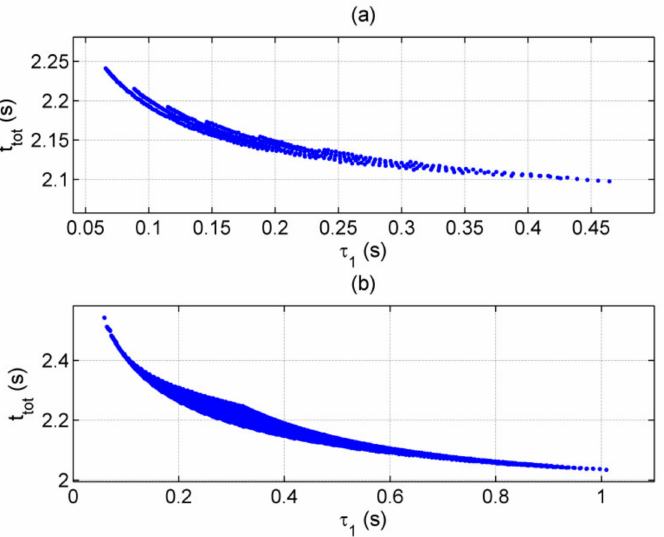
Figure 13. The relationship between the total charging time and time constant τ 1 for the two battery pack structures in the feasible solutions of the Enumeration algorithm, respectively. ( a ) N = 25. ( b ) N = 11.